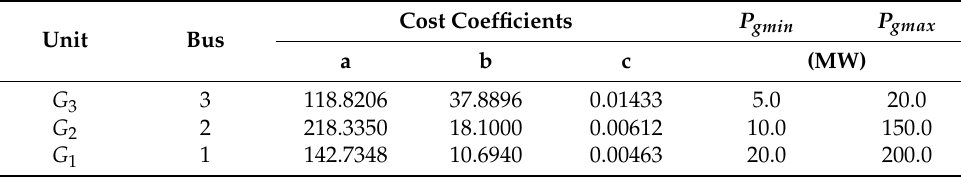
Table 1. Generators cost coefficients and generation